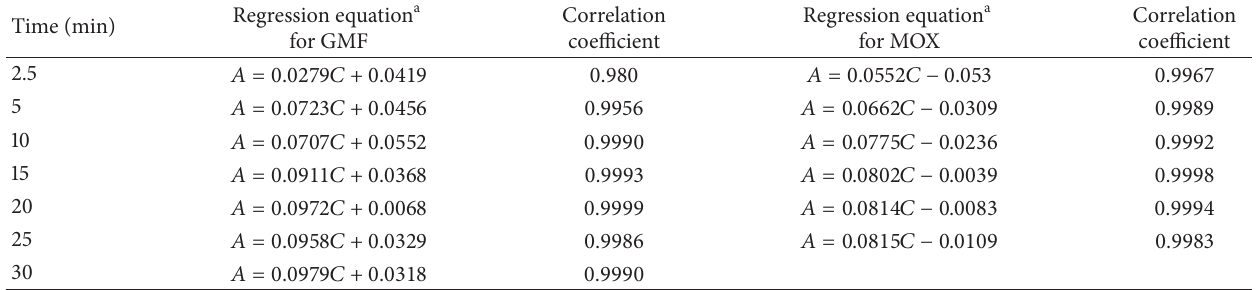
Table 6: Regression equations for GMF and MOX at fixed time and 70 ± 5 ∘